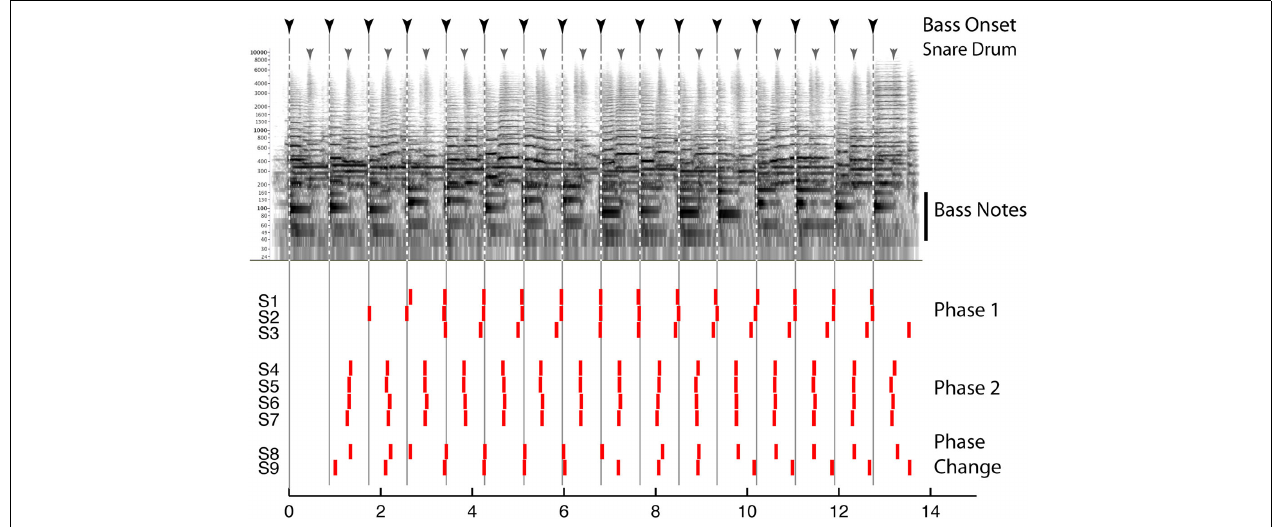
FIGURE 1 | Top: Spectrogram of an excerpt of jazz music (“Stompin at the Savoy,” by Benny Goodman; for corresponding audio, see supplementary sound file 1). Inverted arrows above the spectrogam show times of double